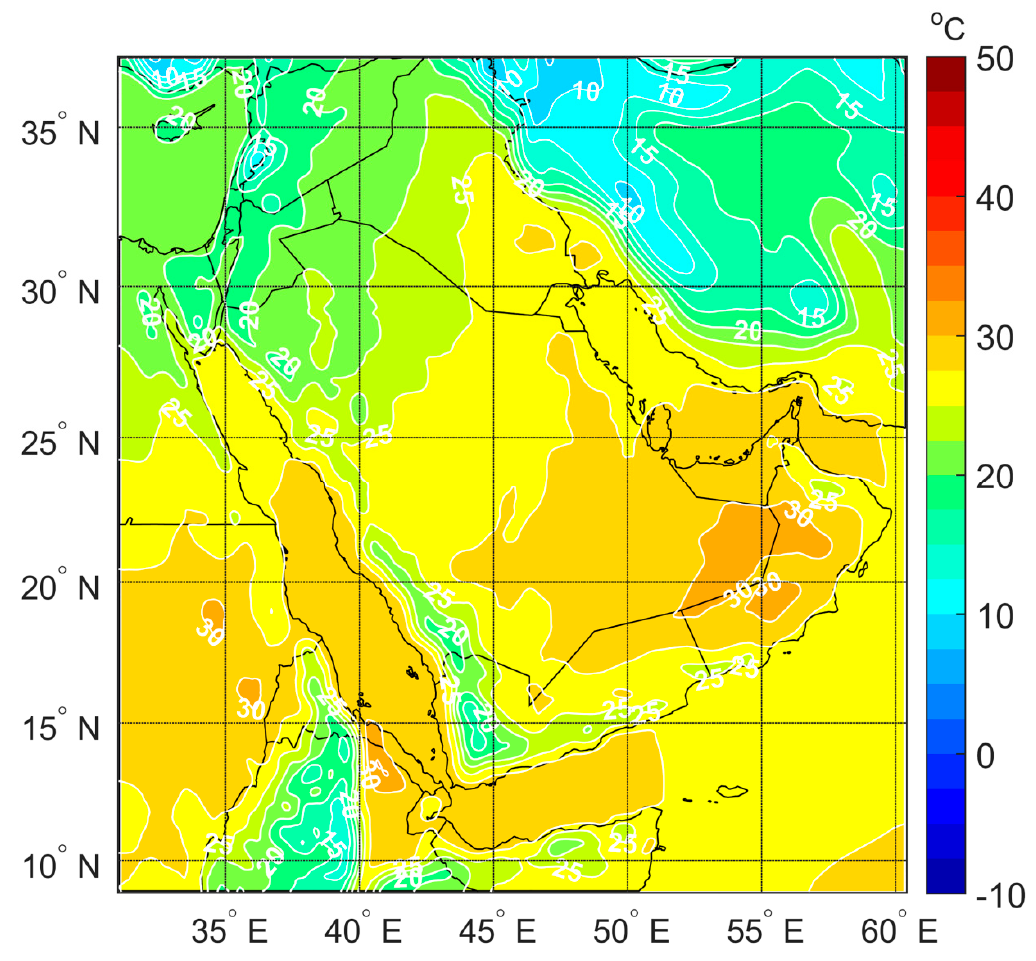
Figure 5. Spatial distribution of the annual mean temperature at 2 m for the period 1986–2015.